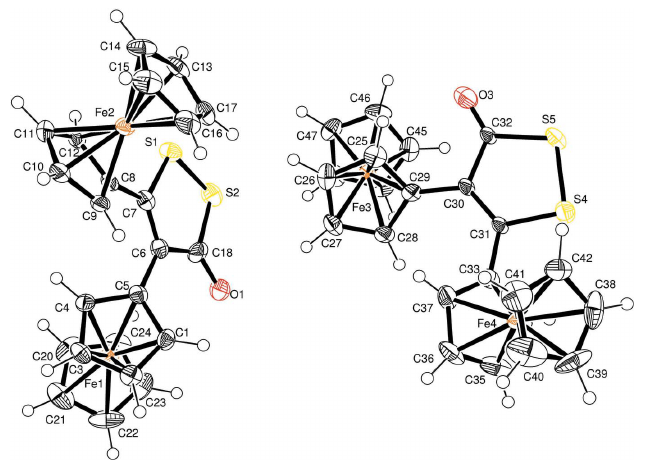
Figure 1 The molecular structures of the two entities in the asymmetric unit. Displacement ellipsoids are drawn at the 50% probability level. Only the major component of disorder is shown for molecule A